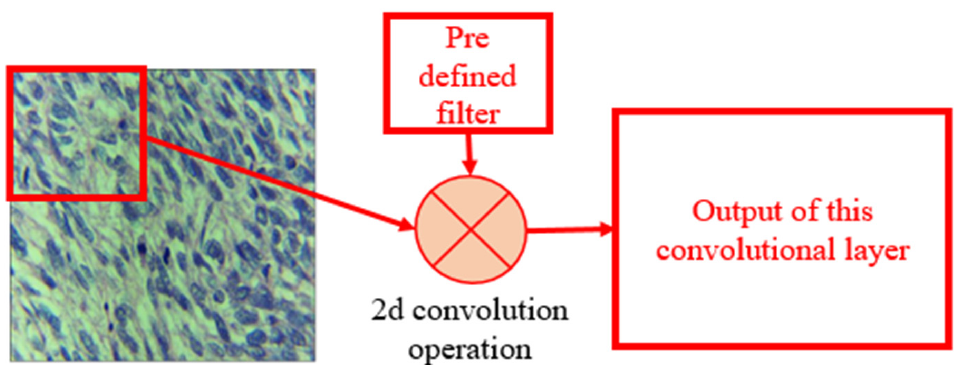
Figure 5. 2D convolution operation for LMS image.